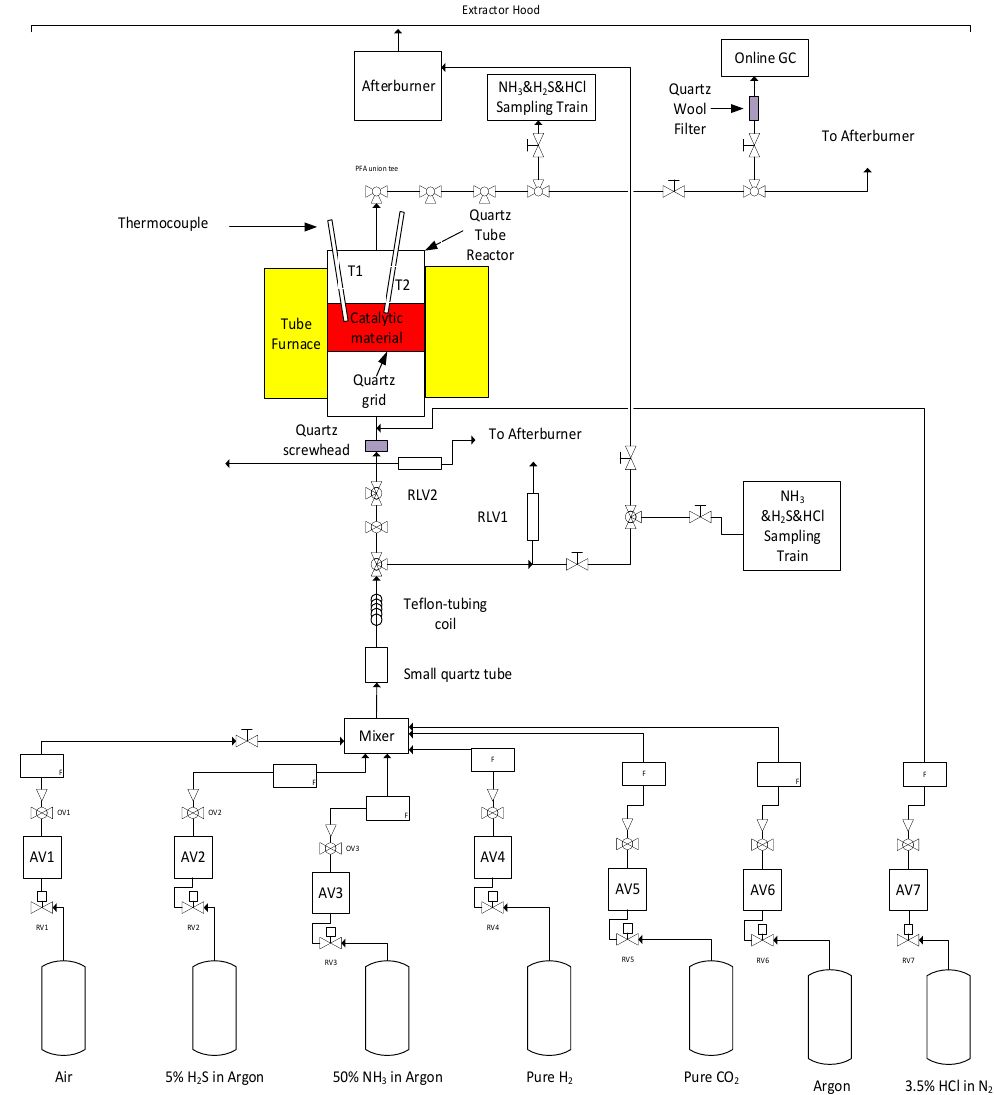
Figure 1. Experimental system used in this study [42].